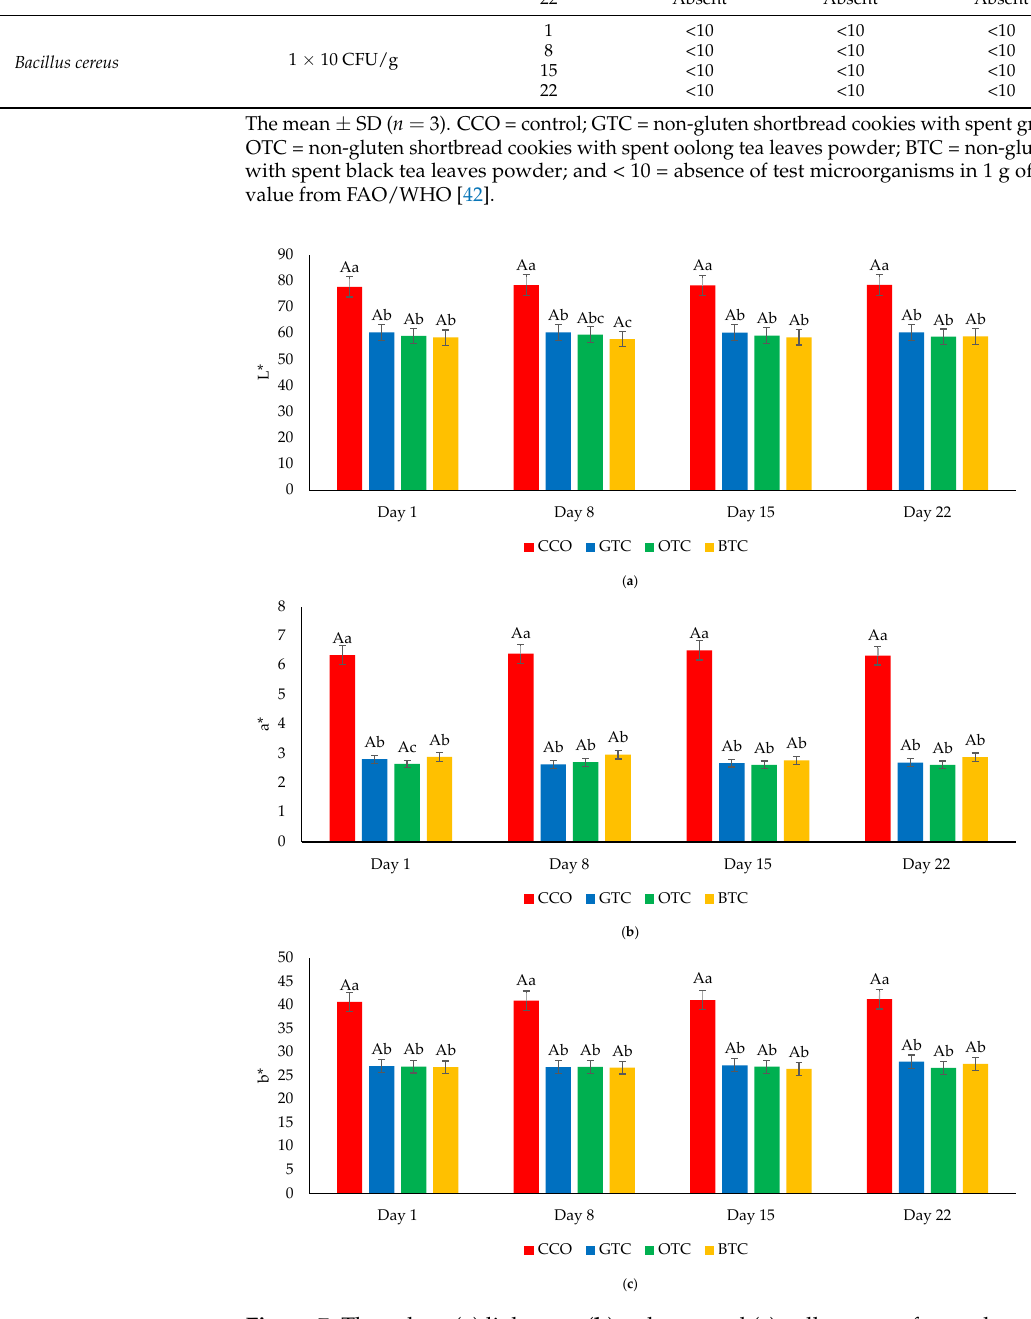
Figure 7. The colour ( a ) lightness, ( b ) redness, and ( c ) yellowness of non-gluten shortbread cookies with various spent tea leaf powders during different storage periods (day 1, 8, 15, and 22) at 25 ◦ C. The mean ± SD ( n = 3). Different letters indicate significant differences between the values (Duncan’s multiple range test, p < 0.05, a,b cookie samples, A storage). CCO = control; GTC = non-gluten shortbread cookies with spent green tea leaves powder; OTC = non-gluten shortbread cookies with spent oolong tea leaves powder; BTC = non-gluten shortbread cookies with spent black tea leaves powder; and L* lightness, a* redness, and b*